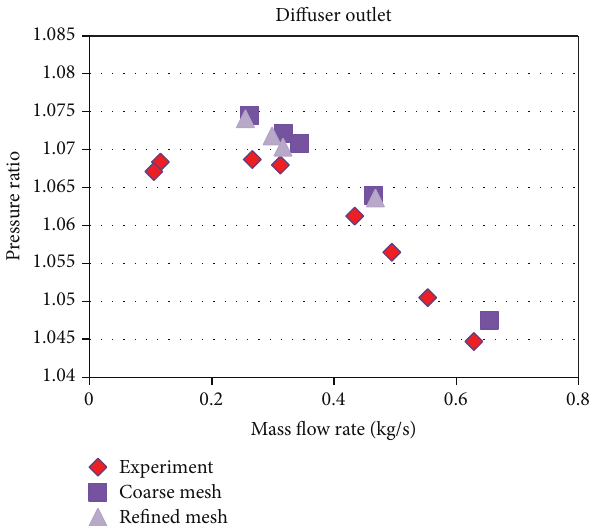
Figure 16: Pressure characteristic at the diffuser outlet for the unsteady case in the diffuser outlet.